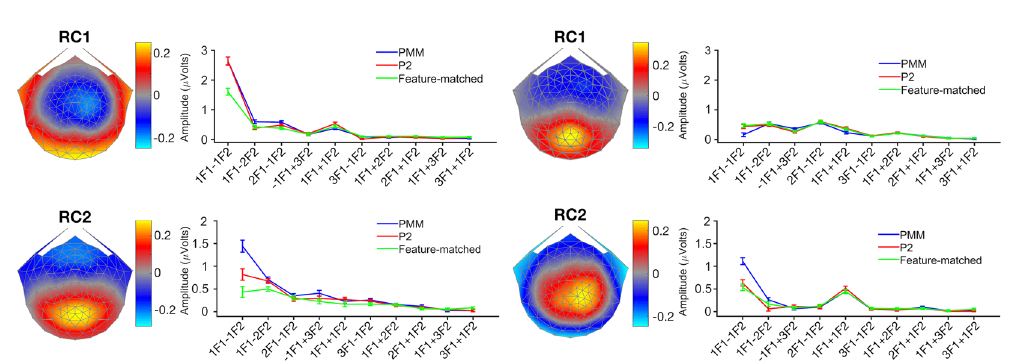
Figure 4. The RC topographies and amplitude of mutual-terms from two frequency pairs. The left column represents the first frequency pair, while the right column represents the second frequency pair. Rows represent two RCs. The first row shows topographies and amplitude values of RC1 from both frequency pairs. The second row shows topographies and amplitude values of RC2 from both frequency pairs. Error bars indicate the standard error of the